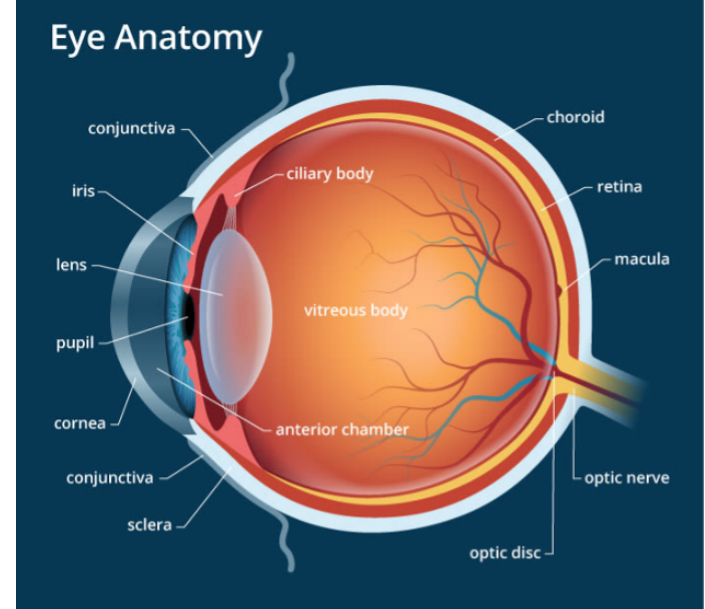
Figure 1. The Structure of the Eye.